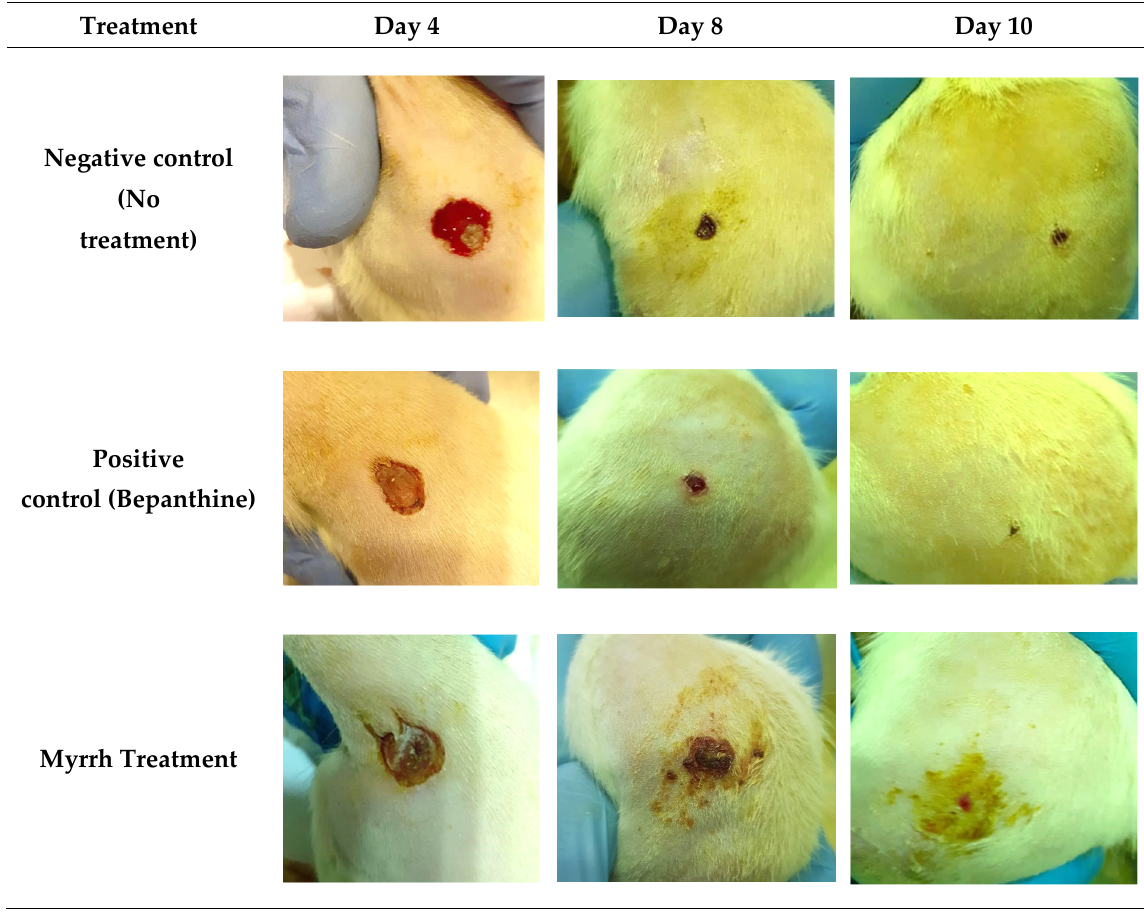
Figure 7. In vivo testing of the anti-inflammatory and wound-healing activity of negative control, bepanthine, and myrrh treatment. Myrrh and bepanthine were noted to enhance wound contraction, hair growth, and proliferative stage maturation of the blood vessels.